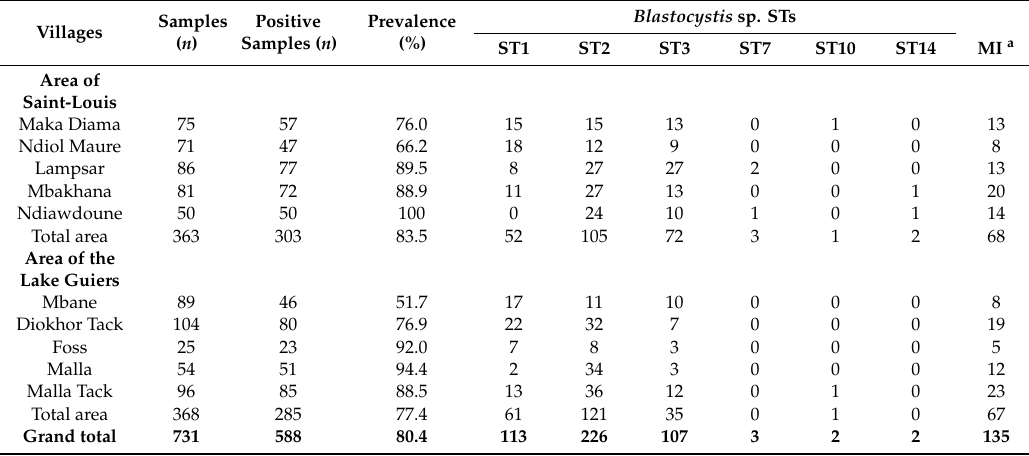
Table 2. Prevalence and ST distribution of Blastocystis sp. in the 10 Senegalese villages screened in the present